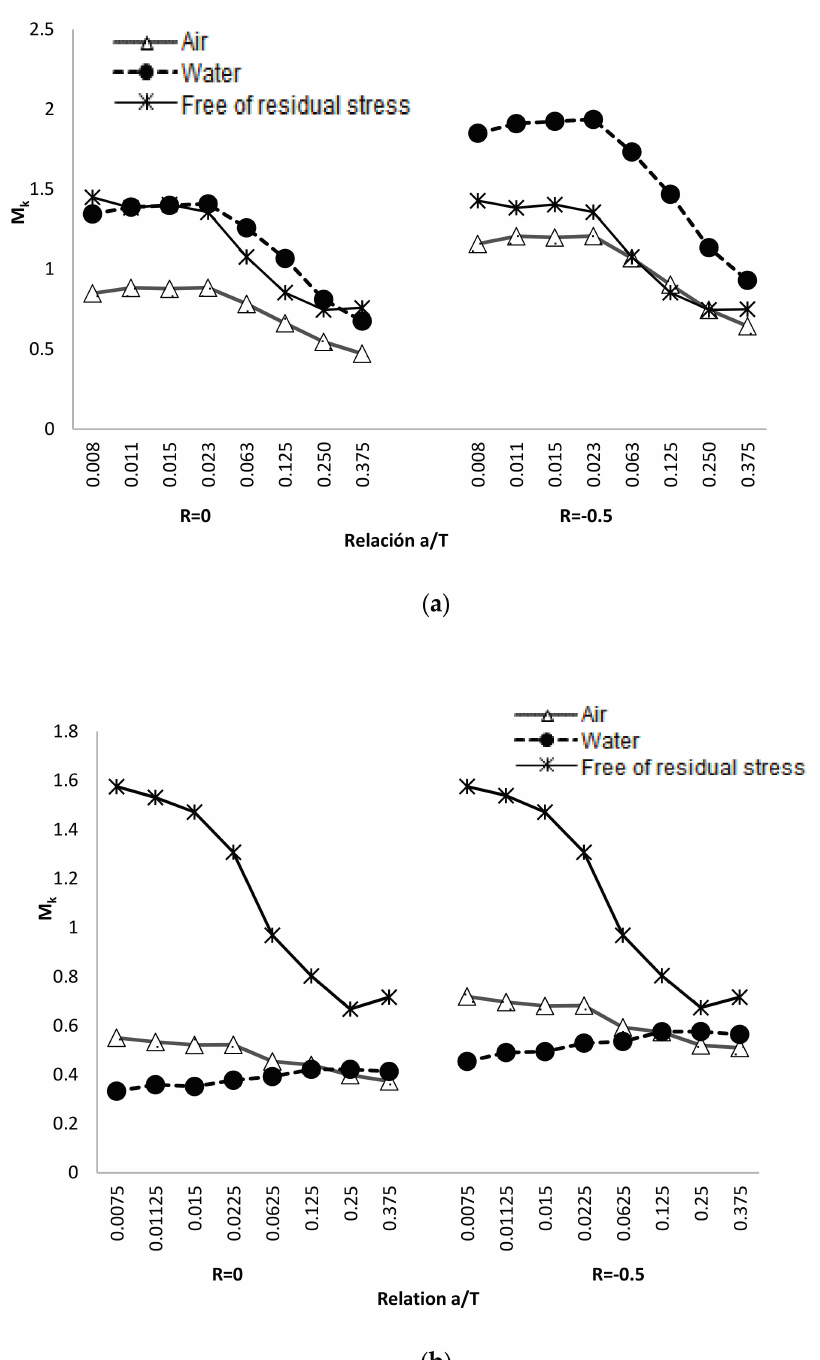
Figure 8. Modified weld magnification factor M k to crack at the weld toe: ( a ) weld size (leg) of 3 mm and ( b ) weld size (leg) of 5